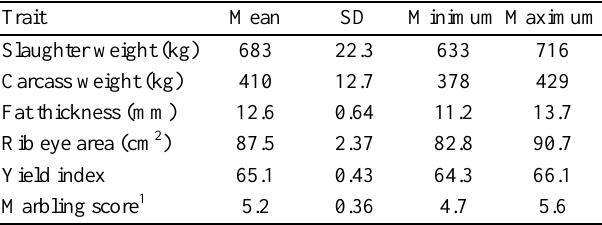
QG frequencies were not correlated (p>0.05) with mean, (Table 8). Mean YG A and YG A plus B frequencies and the yield index for the 8 years were strongly ( r ≥0.71) positively correlated (p<0.01) with mean, maximum, and minimum CT and THI values (Table 8). In contrast, YG C frequency, SW, and BT were strongly negatively ( r ≤–0.69; p<0.05) correlated with all CT and THI values. The CW showed a correlation trend (p<0.1) with the CTs and THI. However, REA was not correlated (p>0.05) with any CT or THI values. Overall, YGFs were associated with CT, but QGFs were not associated with CT.